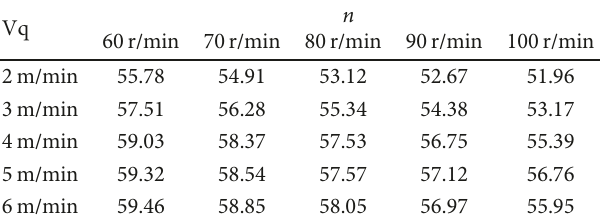
Figure 6: Di ff erent drum speeds and the coal and rock Table 3: The statistical value of the rock stress (MPa).